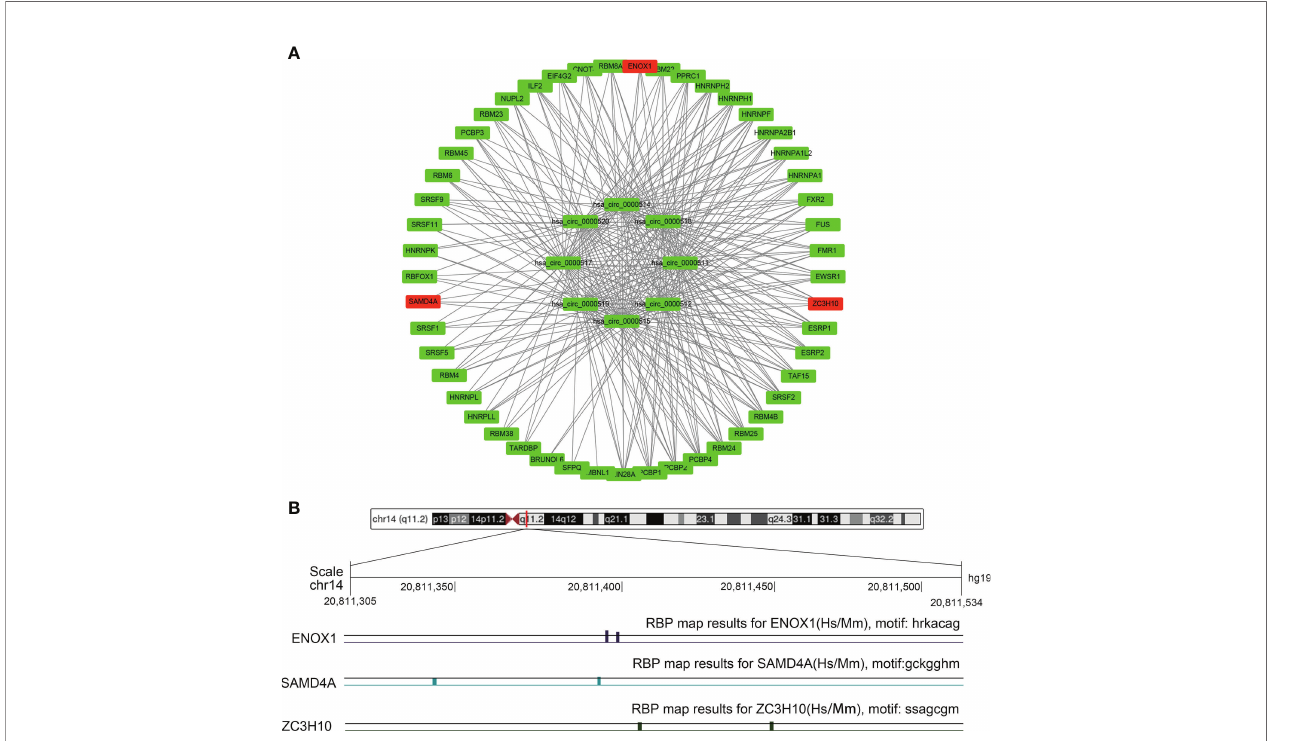
FIGURE 9 | The circRNA – protein network and binding site in the CRC. (A) Circular RNA (circRNA) – protein network in colorectal cancer (CRC) according to the RBPmap. The red nodes represent immune-related proteins, whereas the green nodes represent other proteins and eight circRNAs. (B) Chromosome positions and ENOX1, NCAM1, SAMD4A, and ZC3H10 binding sites of hsa_circ_0000515.